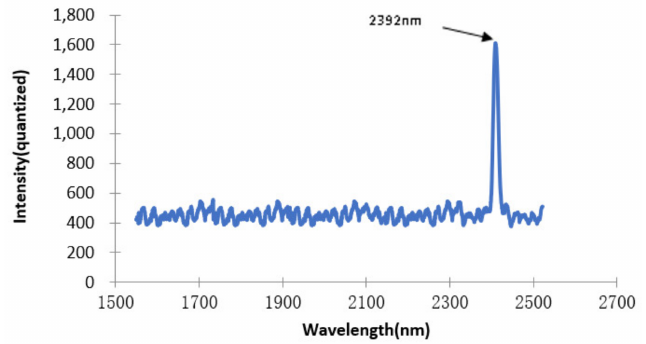
Figure 26. The testing of the resolution of detector